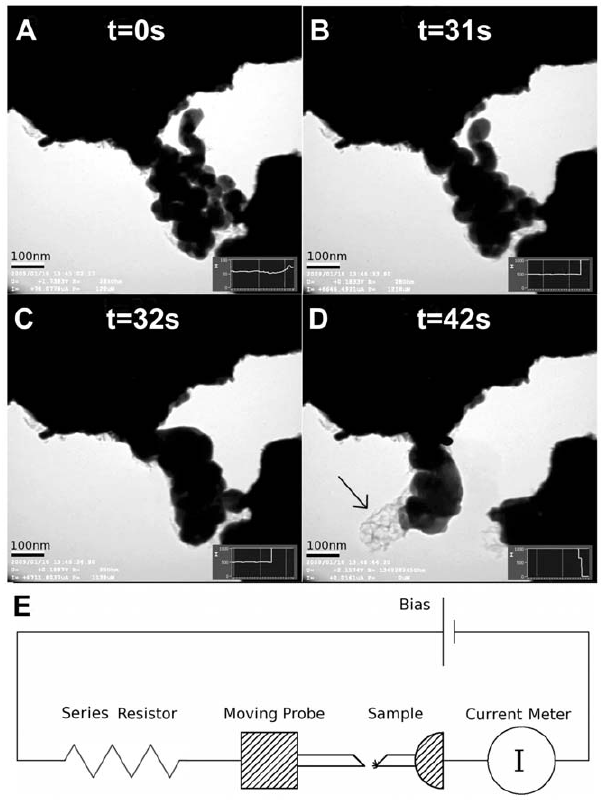
Figure 1. TEM images of the process of electrical sintering and coalescence of silver nanoparticle ink. During increasing electrical current: a) Starting sample with a initial resistance R of 200 k V that slowly drops to R ~ 15 k V . b) Sintering of nanoparticles, that occurred in less than one seccond. R ~ 30 V c) Grain growth of nanoparticles, R ~ 20 V d) Evaporation of silver. The arrow points to a carbonized net- like structure. e) Schematic drawing of the in-situ TEM probe electrical wiring